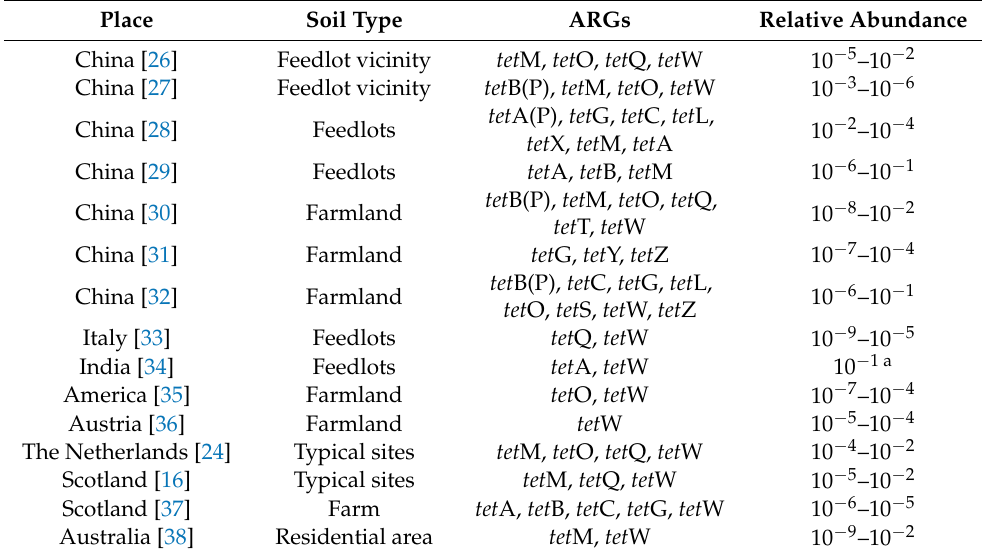
Table 1. Antibiotic-resistance genes (ARGs) contamination in soil (copies/16S rRNA gene).